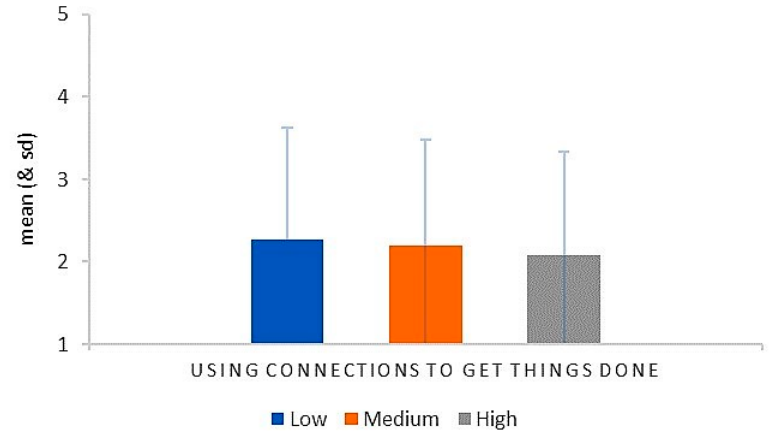
Figure 14. Using connections to get things done by a level of religiosity. (The error bars represent standard deviation).